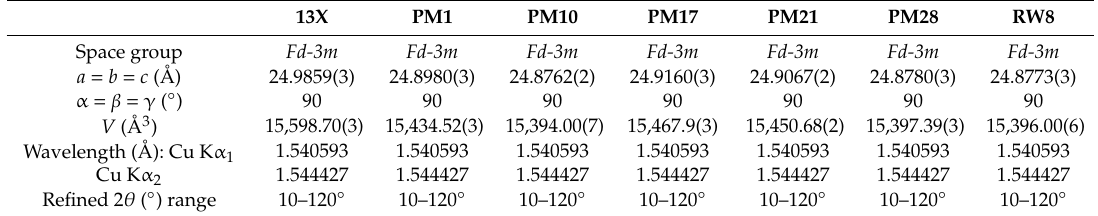
Table 2. Details of the data collection and Rietveld refinements of 13X before and after metals adsorption.